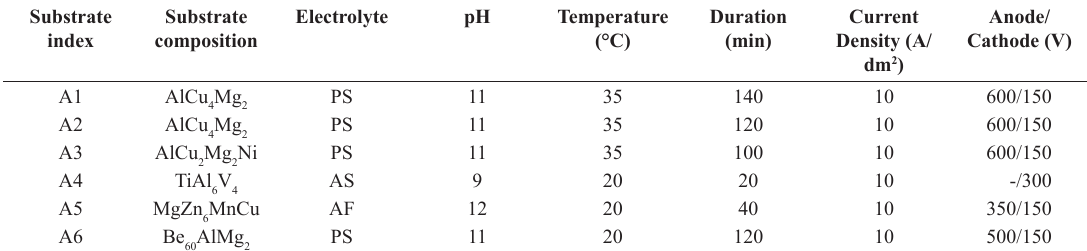
Table 1. PEO experimental conditions. Electrolyte abbreviations are: PS - phosphate-silicate, AS - aluminate-sulfate and AF - aluminate- fluoride. Substrate index